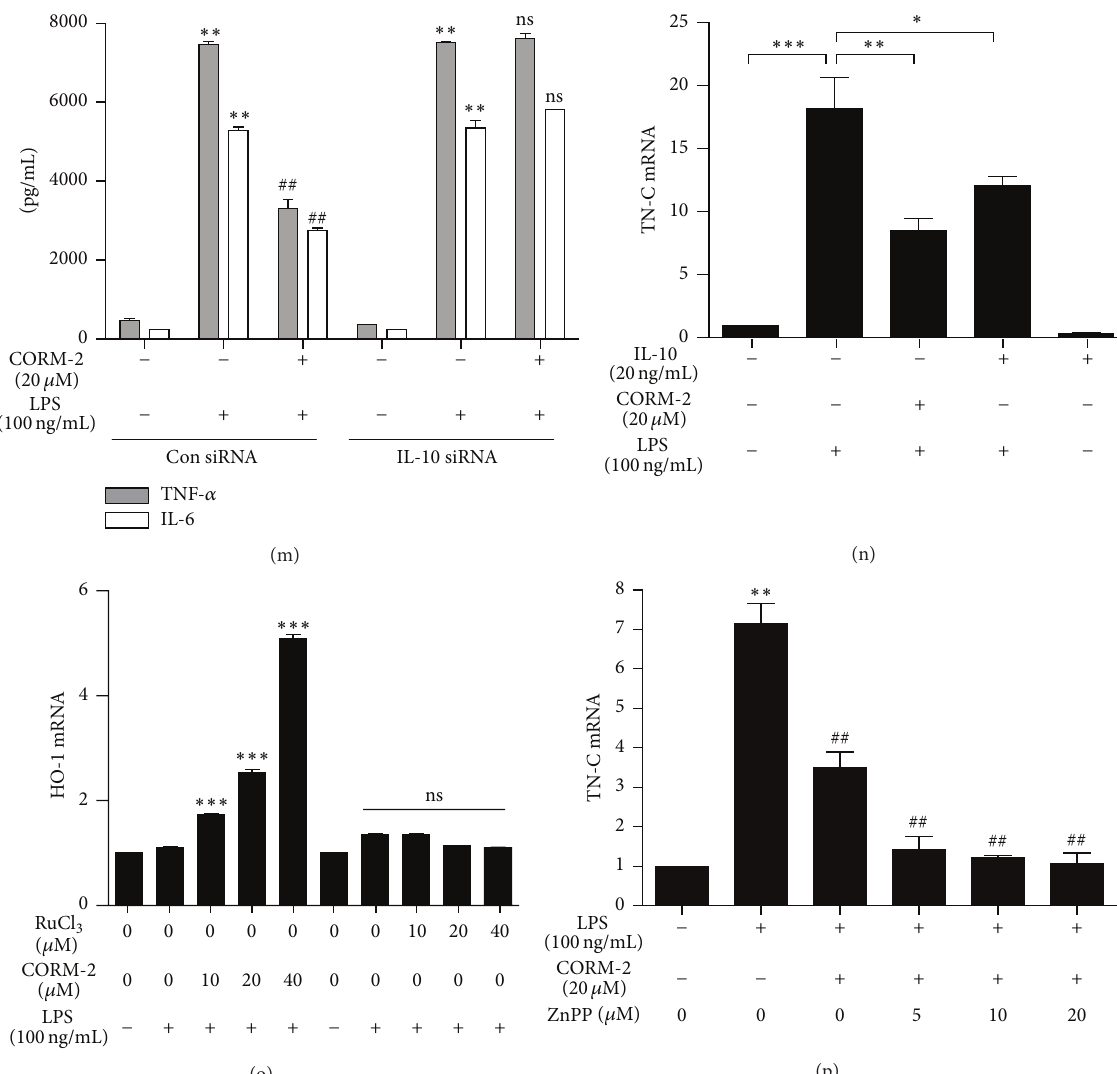
Figure4:COinhibitsTN-C-mediatedinflammation via IL-10inductioninRAW264.7macrophagesandperitonealmacrophages. (a-b)Cells were pretreated with CORM-2 (0, 10, 20, and 40 𝜇 M) for 1h and then stimulated with LPS (100ng/mL) for 8 h. IL-10 mRNA level was detected by Real Time RT-PCR in RAW 264.7 (a) and peritoneal macrophages (b). After treatment of CO gas (250ppm) for 2 h and being incubated with LPS (100ng/mL) stimulated for 8h, IL-10 mRNA level was detected by Real Time RT-PCR (c). (d-e) Cells with CORM-2 (20 𝜇 M) or RuCl 3 (20 𝜇 M) for 1 h were stimulated with LPS (100ng/mL) for 8 h. IL-10 mRNA levels increased with CORM-2 which was detected by Real Time RT-PCR in RAW 264.7 (d) and peritoneal macrophages (e). RuCl 3 was used as a negative control for CORM-2. (f–i) RAW 264.7